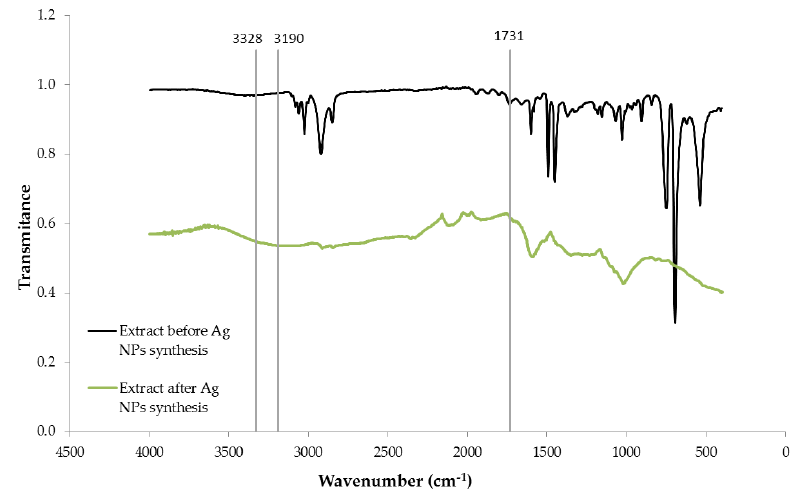
Figure 2. FTIR spectrum of dried grape stalks extract before and after the synthesis of Ag-NPs.